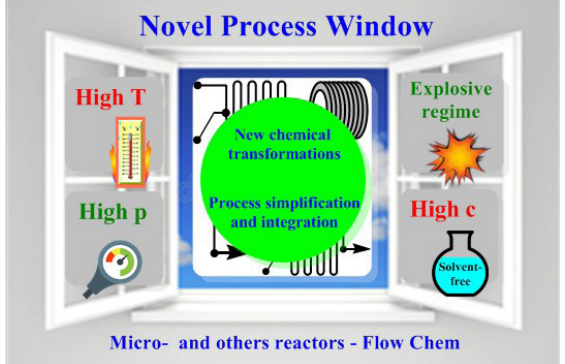
Figure 4 - An overview on Novel Process Windows